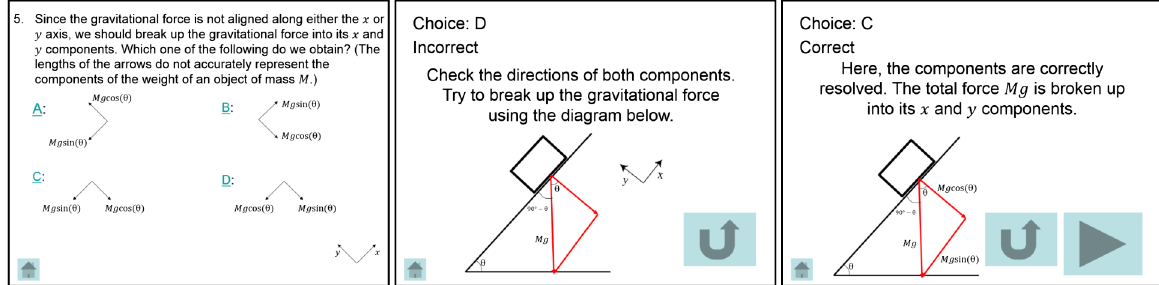
FIG. 2. Example of a subproblem from the tutorial focusing on Newton ’ s second law and adaptive support provided if the student provides an incorrect or a correct response. Students can either click on a particular option in the multiple choice or click on the home button in order to access any of the previous subproblems and associated help.